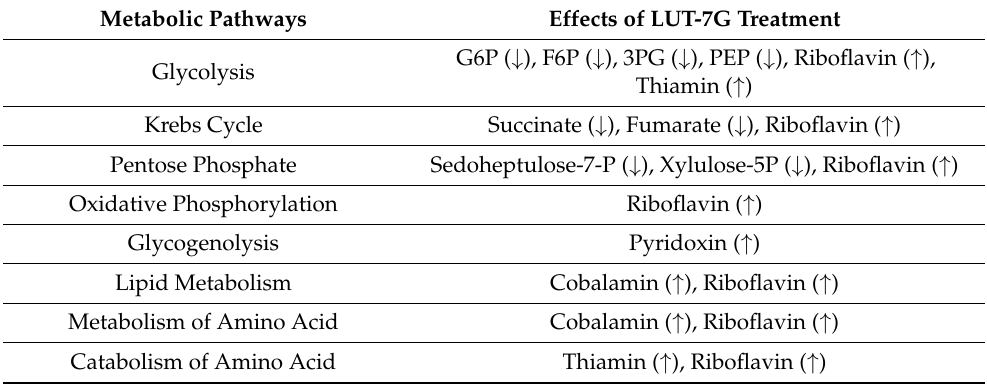
Table 7. Modulation of metabolites and vitamins by LUT-7G treatment on human keratinocytes. Metabolic Pathways Glycolysis